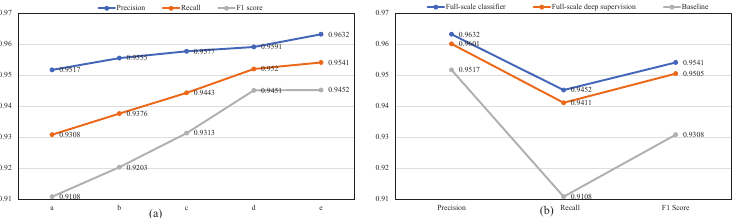
Figure 4. The comparison results between the different classifiers in Figure 3: classifiers a to e are compared in ( a ), and classifiers a , e , and f are compared in ( b